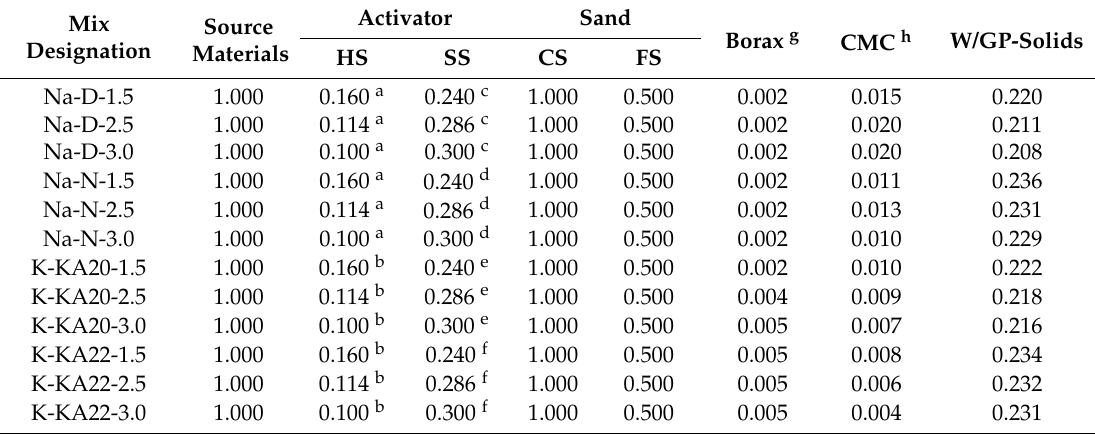
Table 3. The mixture proportions of 3D printable geopolymers.